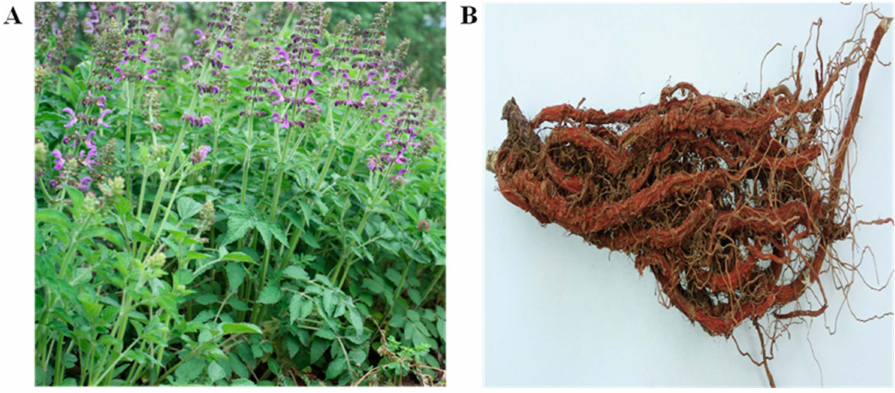
Figure 1. The Salvia miltiorrhiza Bunge ( A ) and the raw herb of S. miltiorrhiza Bunge ( B